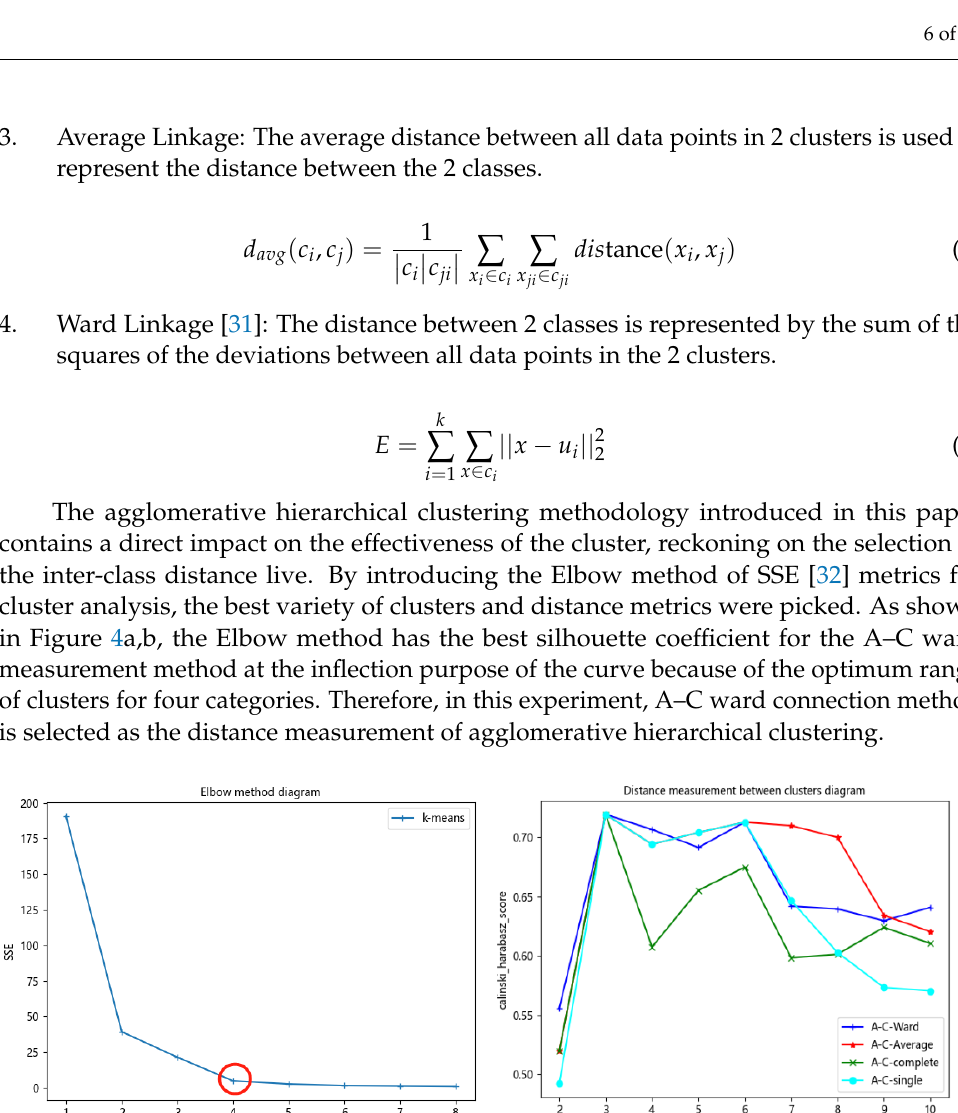
Figure 5. Heatmap using the ward connection mode condensation hierarchy.